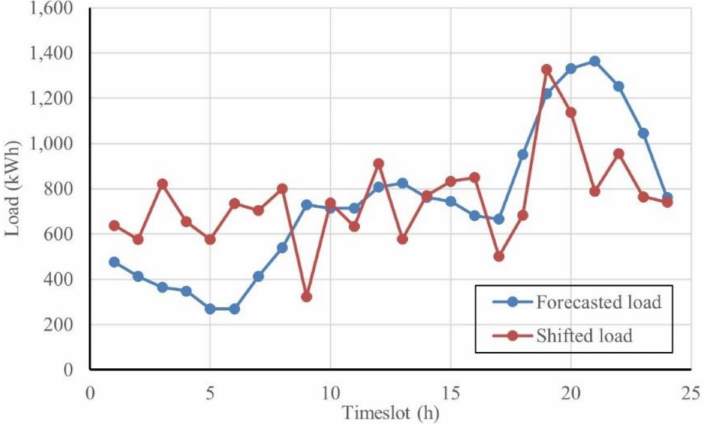
Figure 17. Hourly residential load before and after DSM using the centralized algorithm